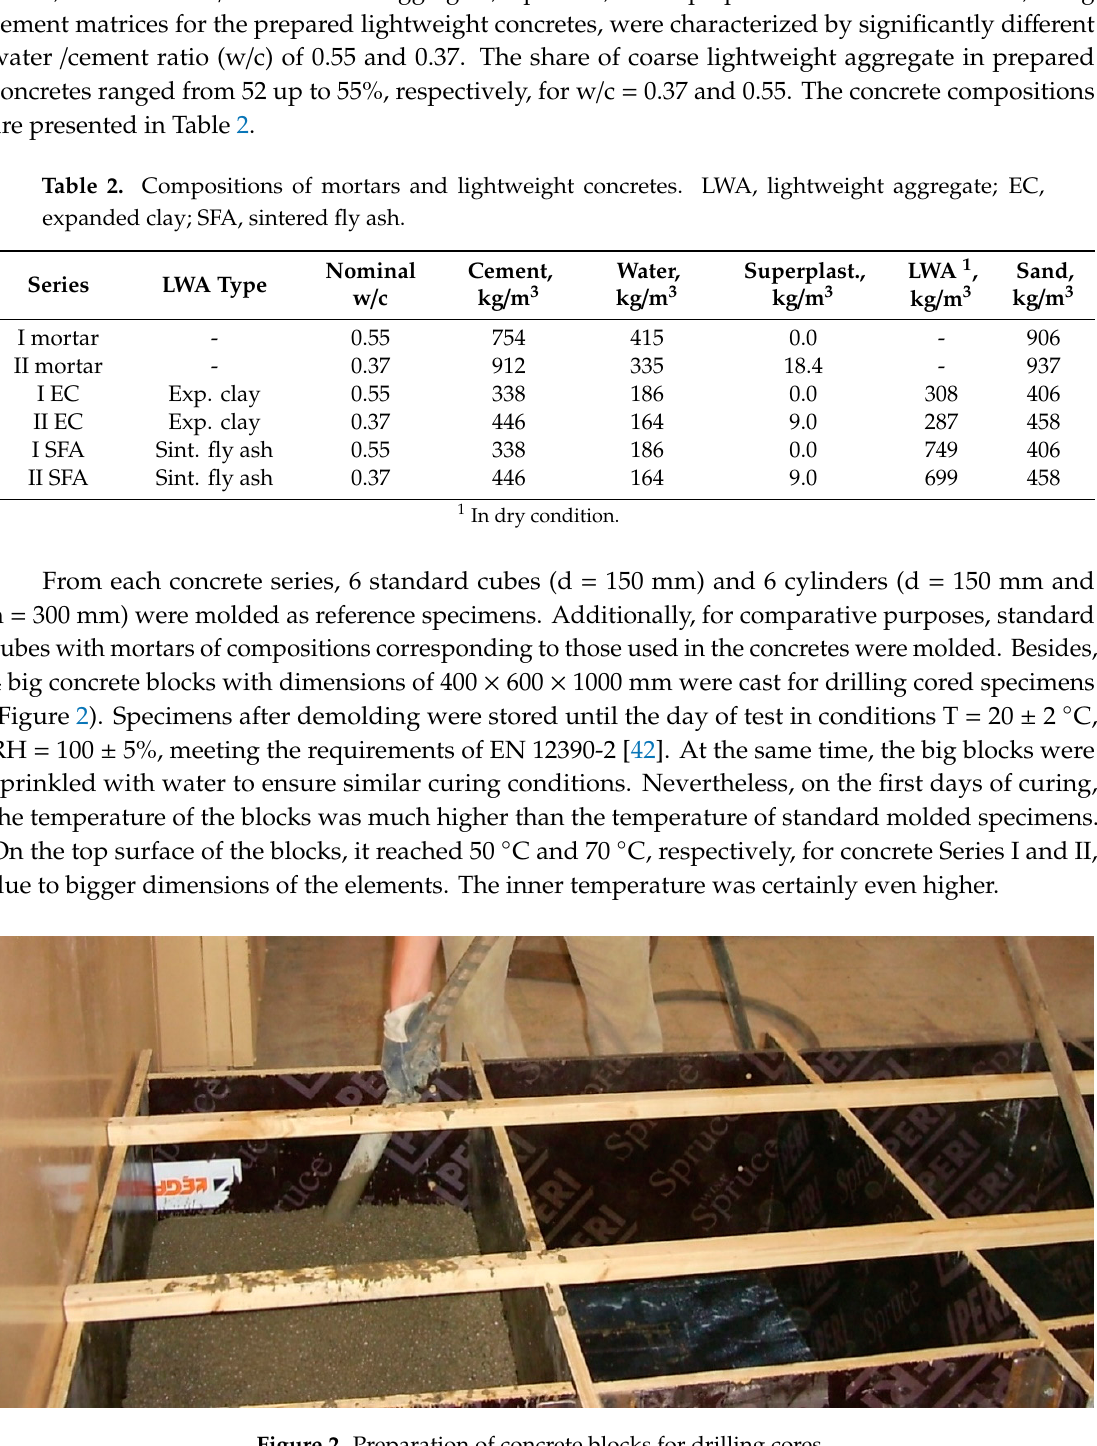
Figure 2. Preparation of concrete blocks for drilling cores.